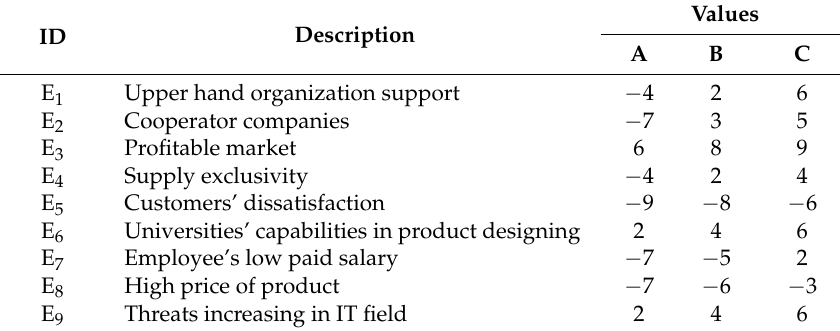
Table 2. External factors.